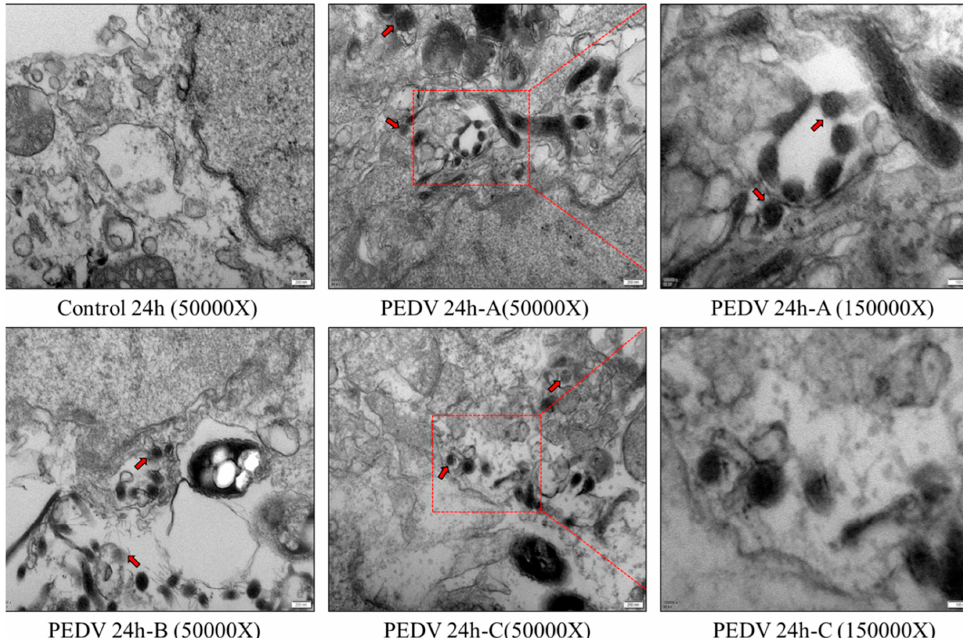
Figure 5. Electron microscopy results of PEDV-infected FHs 74 Int cells. No virus particles were observed in the cell control group, and virus particles could be observed in FHs 74 Int cells at 24 h post-infection. Magnification 50,000 × and 150,000 × . The red box represents the enlarged part of the figure on the right; The arrows show the virus, the PEDV